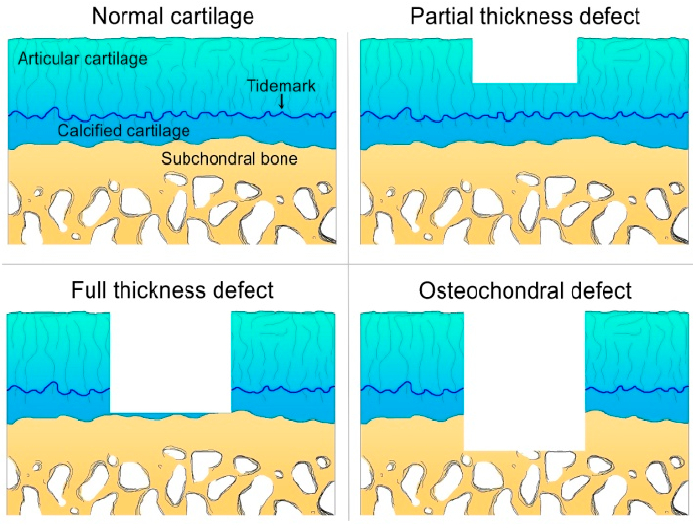
Figure 1. Types of cartilage defects. Partial thickness defect develops only in the articular cartilage. In full-thickness defect, the subchondral bone plate is exposed, but not disturbed. The osteochondral defect develops in the cartilage and subchondral bone.